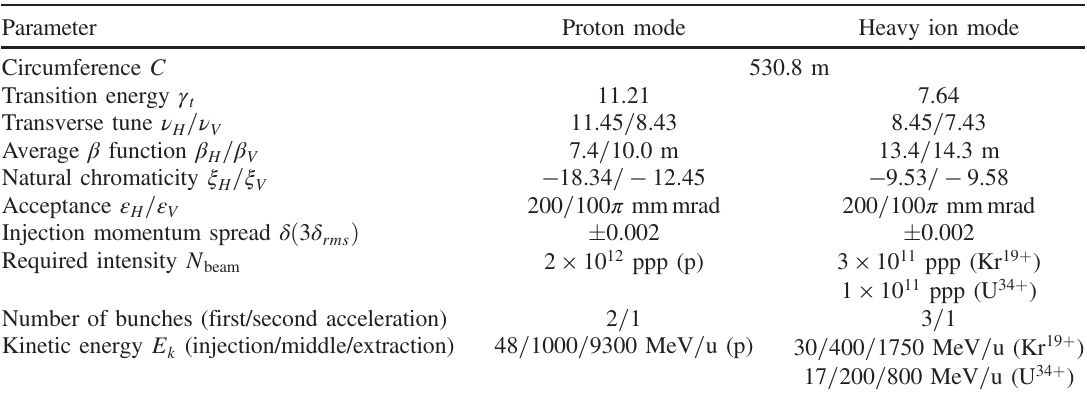
TABLE I. The main parameters of the